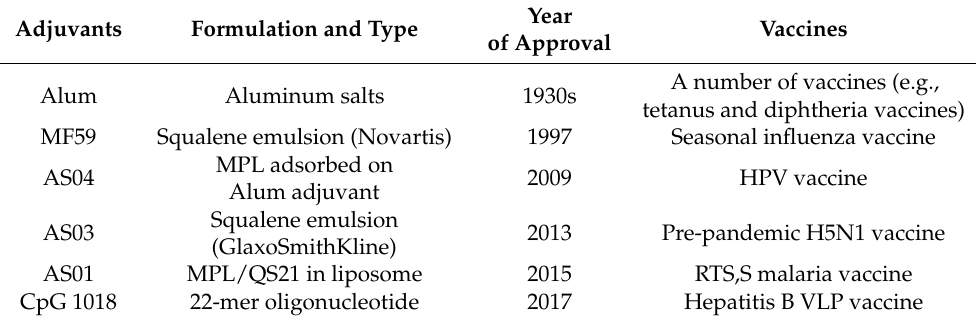
Table 2. List of licensed vaccine adjuvants. Year Vaccines Adjuvants Formulation and Type of Approval A number of vaccines (e.g., Alum Aluminum salts 1930s tetanus and diphtheria vaccines) MF59 Squalene emulsion (Novartis) 1997 Seasonal influenza vaccine MPL adsorbed on AS04 2009 HPV vaccine Alum adjuvant Squalene emulsion AS03 2013 Pre-pandemic H5N1 vaccine (GlaxoSmithKline) AS01 MPL/QS21 in liposome 2015 RTS,S malaria vaccine CpG 1018 22-mer oligonucleotide 2017 Hepatitis B VLP